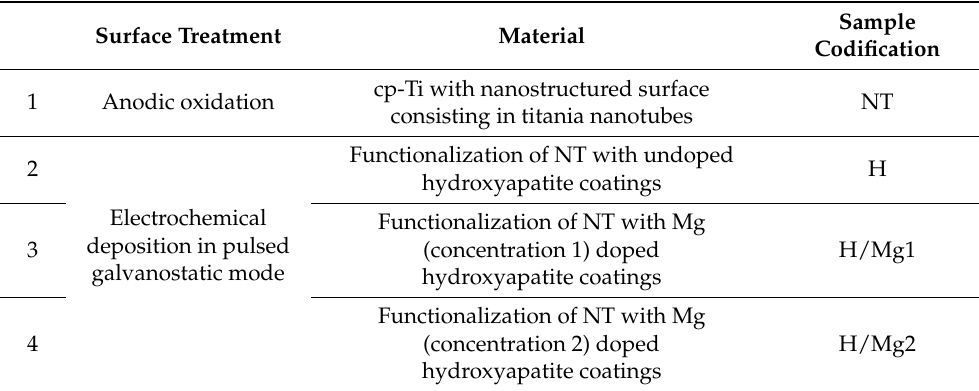
Table 1. Samples